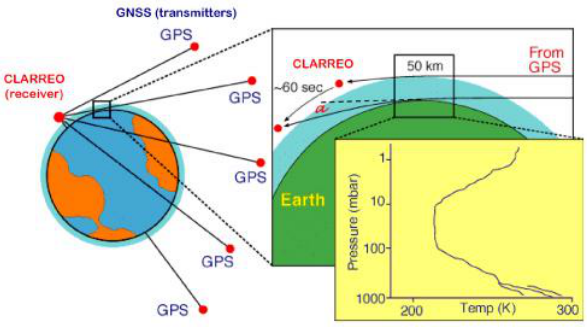
Figure 10. Radio Occultation Instrument Concept Currently, there are only two frequencies, L1 and L2, at which the GPS satellites operate. There are more frequencies that future GPS systems (2016+) will use for operation that CLARREO would benefit from; however, the minimum scientific goals can be accomplished using ~2000 occultation measurements per day of the L1 and L2 frequencies. These occultation signals will be collected using a pair of array antennas, one in the ram and one in the wake on orbit. A variety of RO options are currently under investigation including laser ranging and other techniques that will provide the RO measurements combined with precise on orbit location measurements necessary to meet the CLARREO science